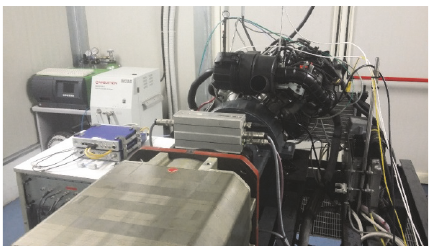
Figure 1: Experimental